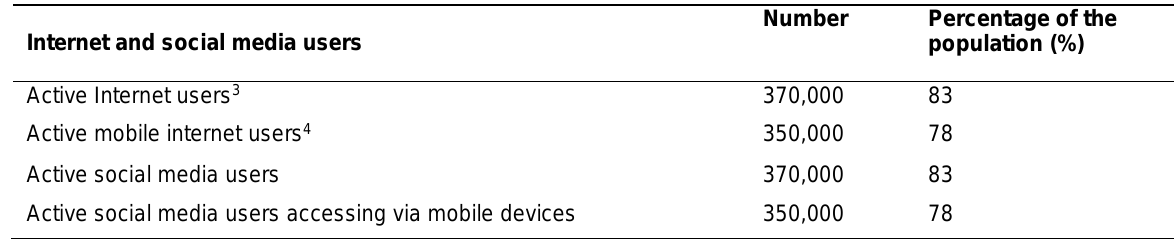
Table 2. ICT use in the Maldives